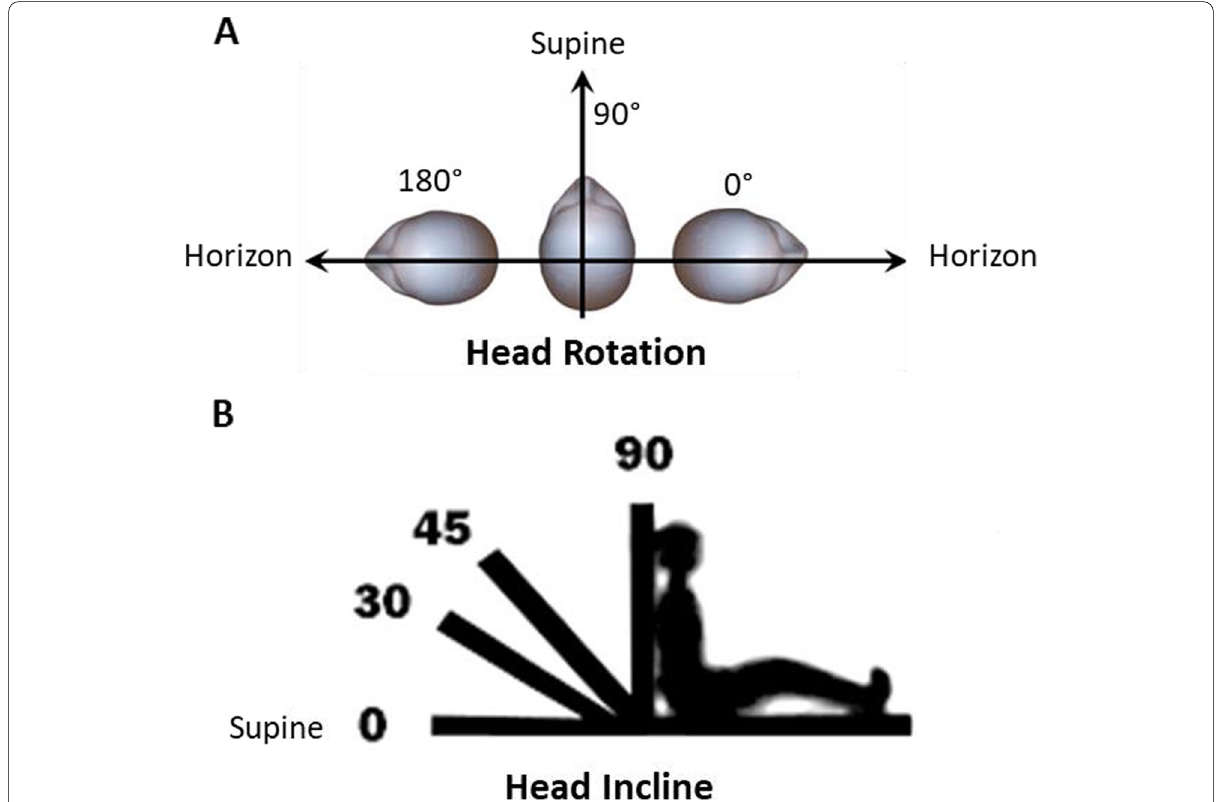
Fig. 1 Head rotation angle definitions ( A ). Head incline angles based on Fowler’s positioning model ( B